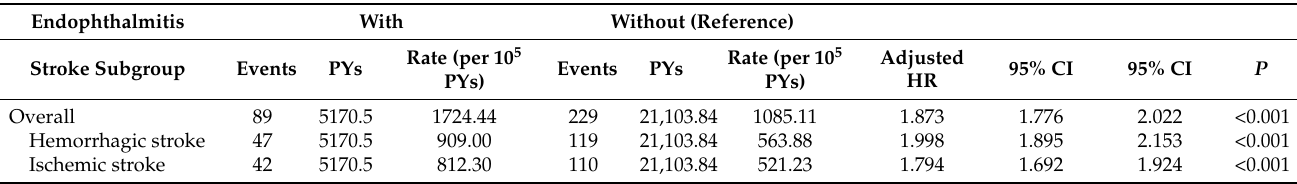
Table 5. Factors of stroke subgroup by using Cox regression